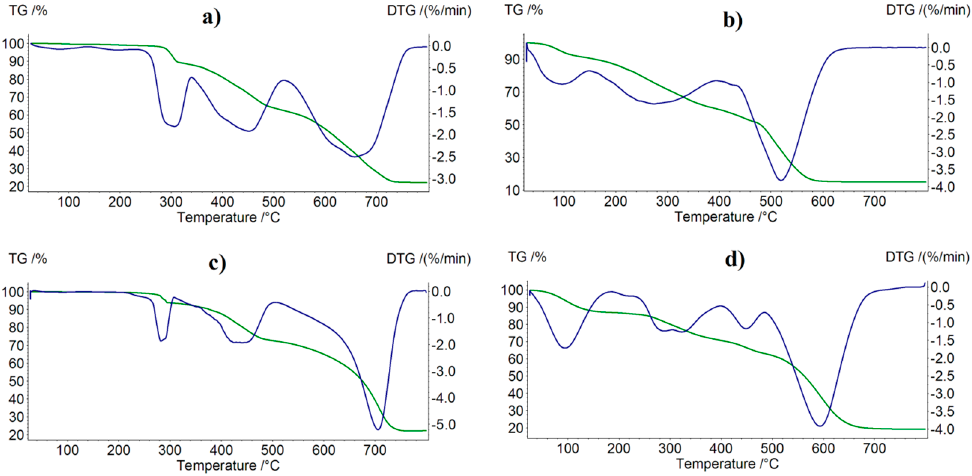
Figure 3. TG (green) and DTG (blue) curves of complexes decomposition in air: ( a ) Mn(L)Cl 2 , ( b )